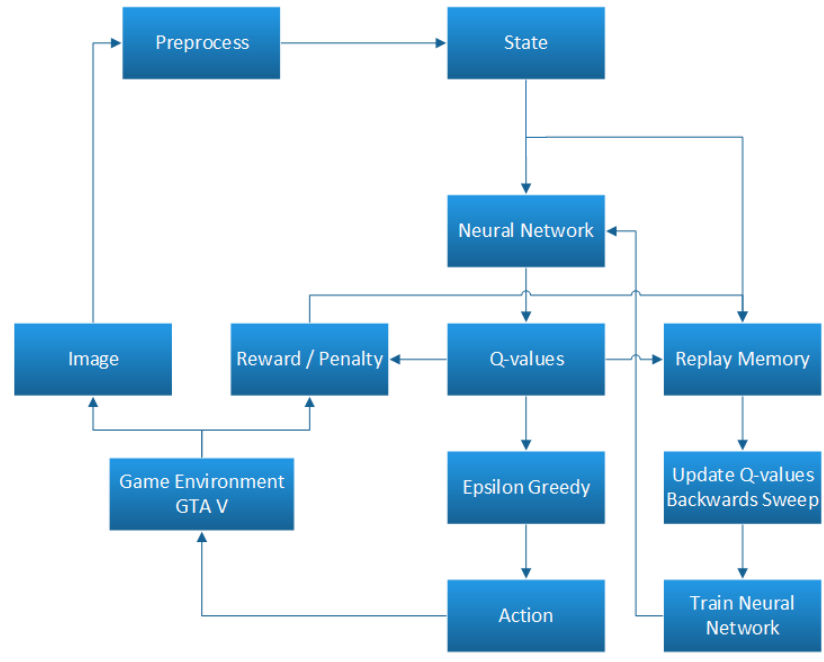
Figure 4. Flow diagram of recommended DDQN